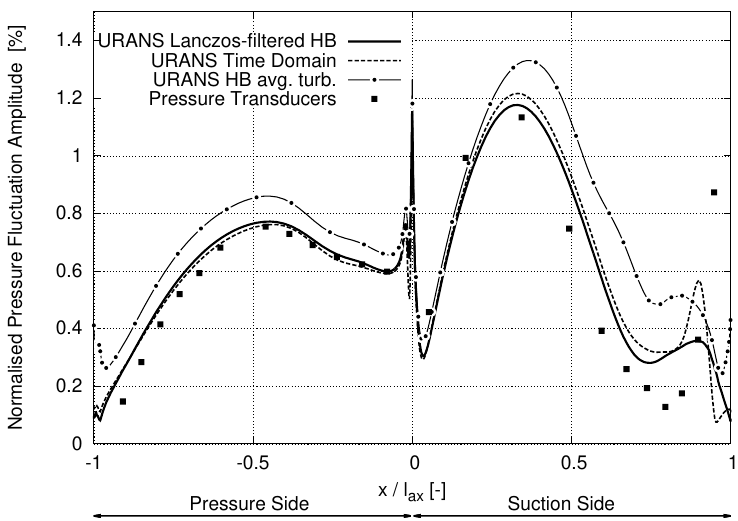
Figure 5. Pressure fluctuation amplitude, normalized by leading edge stagnation pressure, at WGPF along the axial chord length l ax of the excited LPT stator